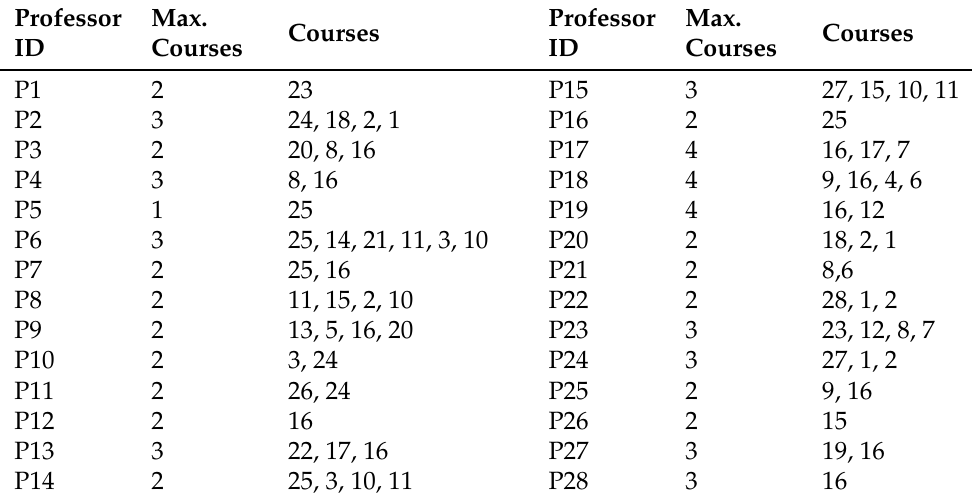
Table 1. Information of